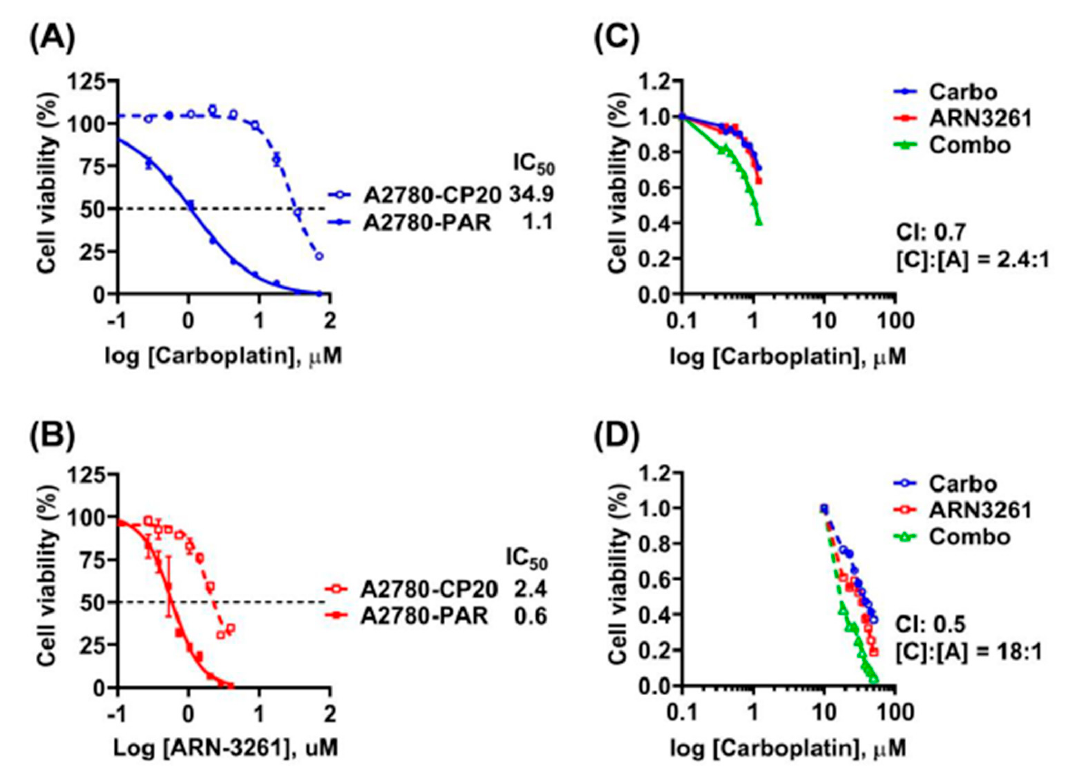
Figure 5. Treatment with ARN-3261 enhances carboplatin toxicity in cisplatin-sensitive and cisplatin-resistant sublines. ( A ) A cisplatin-resistant ovarian cancer cell subline is also resistant to carboplatin. Cisplatin-resistant A2780-CP20 and cisplatin-sensitive A27801 PAR sublines were plated at a density of 2000/well in 96-well plates, then treated with different concentrations of carboplatin for 96 h as indicated. Cell viability was measured with a bioluminescence assay and the IC50 was calculated. ( B ) Growth of both cisplatin-resistant and cisplatin-sensitive sublines are inhibited by ARN-3261 as indicated. Cells were similarly cultured and treated for 96 h with different concentrations of ARN-3261, before measuring cell viability and calculating IC50. ( C , D ). The interaction of ARN-3261 and carboplatin in cisplatin sensitive ( C ) and cisplatin resistant cell lines was evaluated by the combination index at 50% growth inhibition using CalcuSyn software.